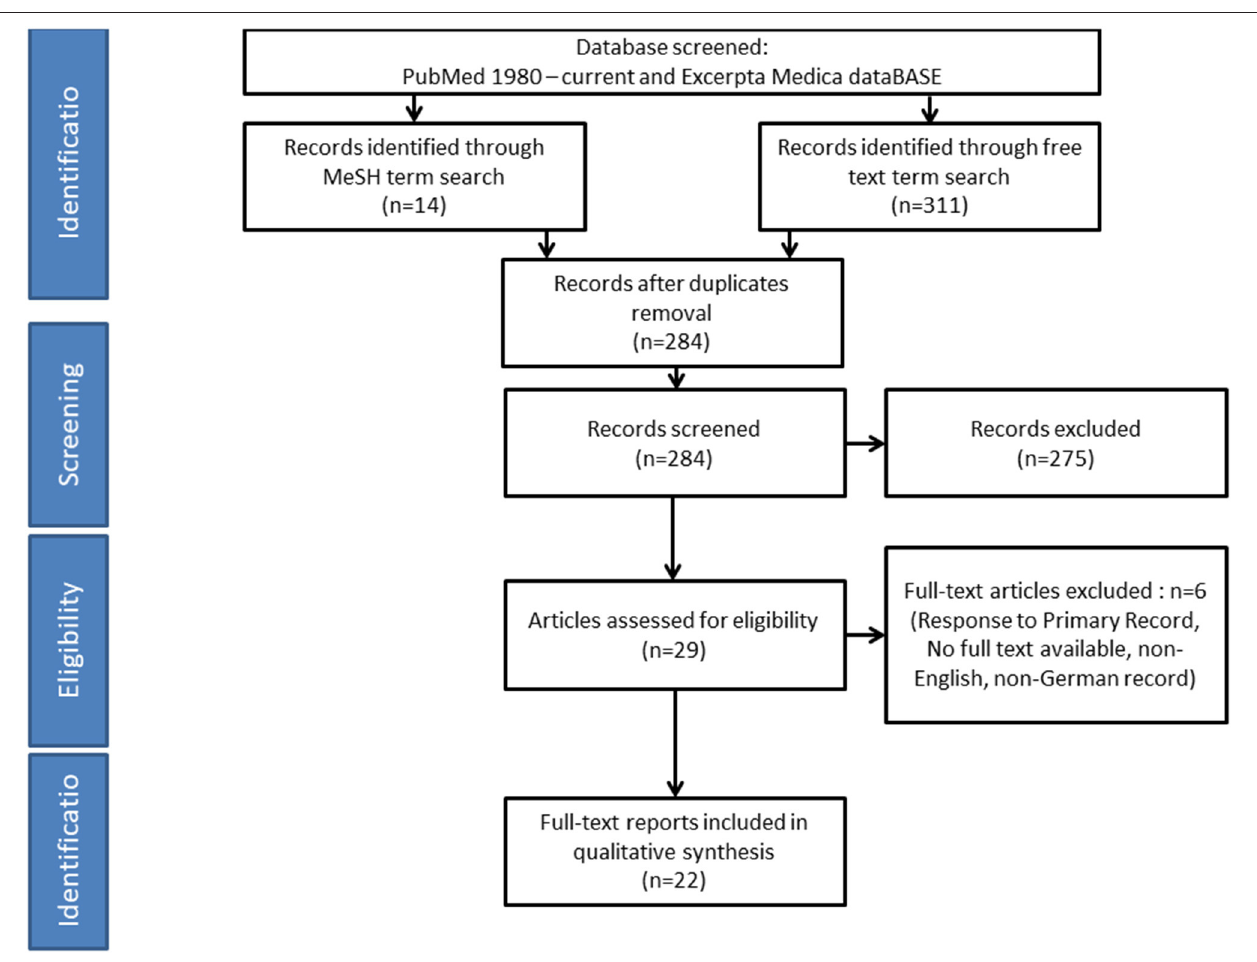
FIGURE 1 | Literature review—summary of search and review process. Several reports included more than one patient, resulting in a total of 28 patients from 22 accessible reports.